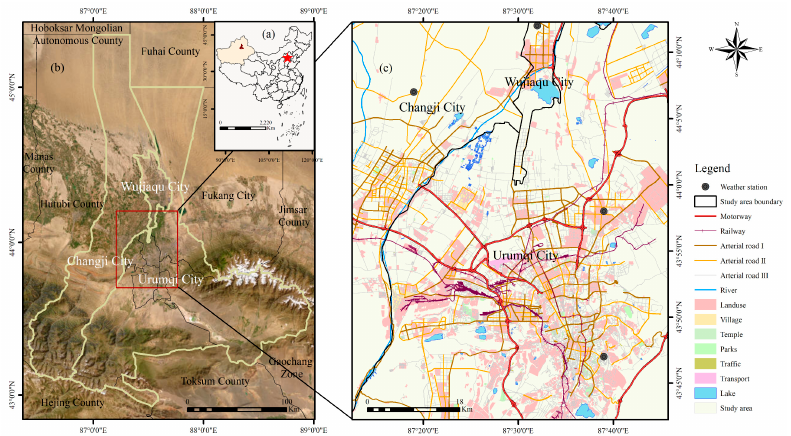
Figure 1. Location of the study area: ( a ) China; ( b ) Urumqi–Changji–Wujiaqu metropolitan area; ( c ) Urumqi-Changeji-Wujiaqu metropolitan area partial.